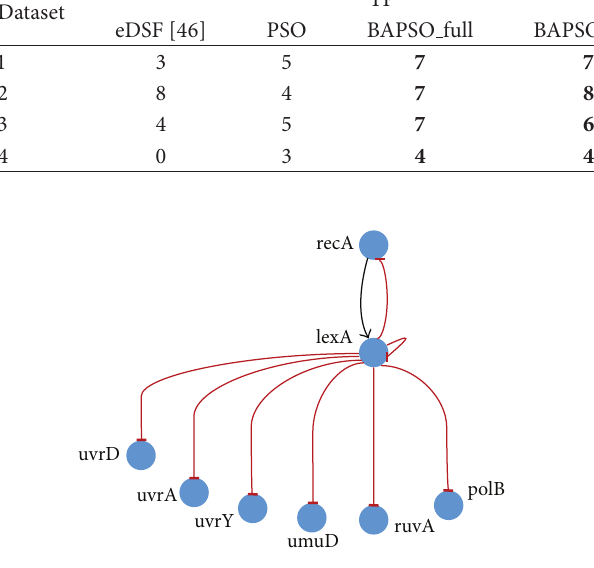
Figure 5: The original structure of the SOS DNA repair transcrip- tional network of E . coli .